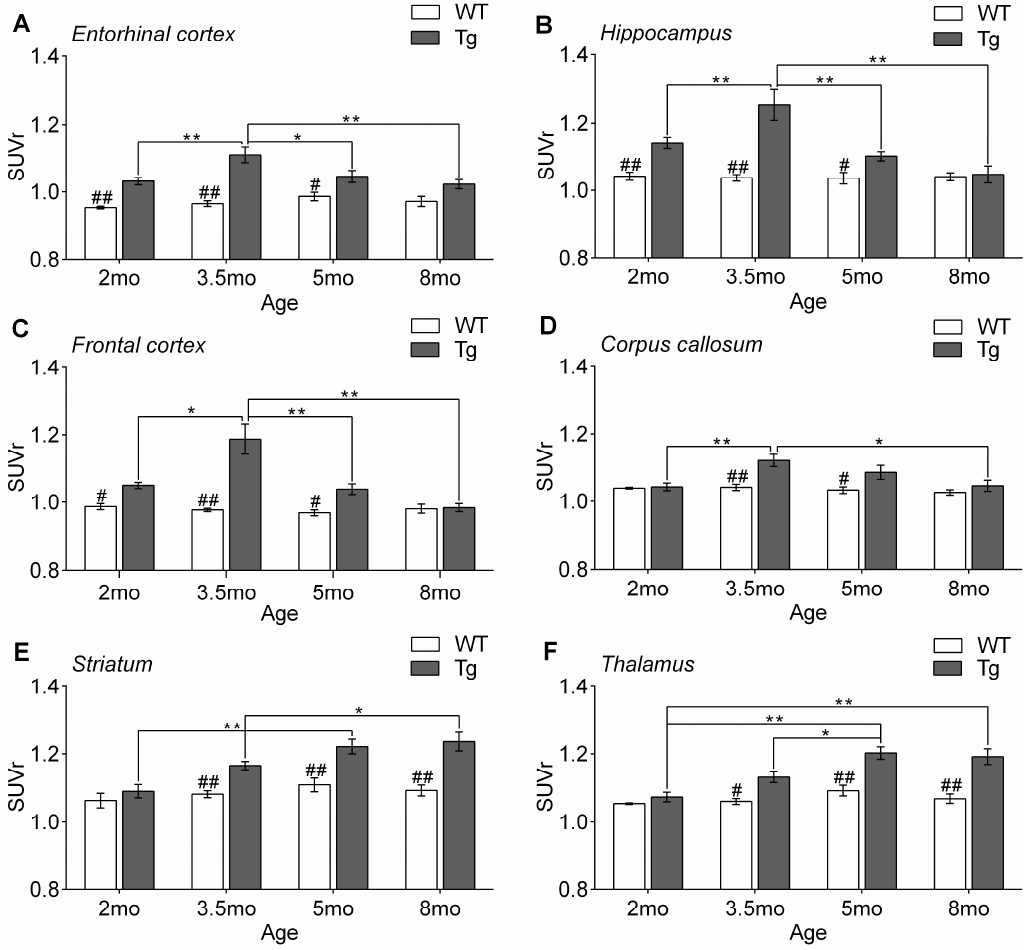
Figure 4. Quantitative analysis of PET data. ROI-based SUVr (relative standardized uptake value) group comparisons for Tg and WT mice aged 2, 3.5, 5 and 8 mo. Graphs highlight age-specific changes in SUVr values for the entorhinal cortex ( A ); hippocampus ( B ); frontal cortex ( C ); corpus callosum ( D ); striatum ( E ); and thalamus ( F ). (* p < 0.05, ** p < 0.01, vs. Tg mice of other age groups; # p < 0.05, ## p < 0.01 vs. Tg mice of the same age group). mo: month-old.